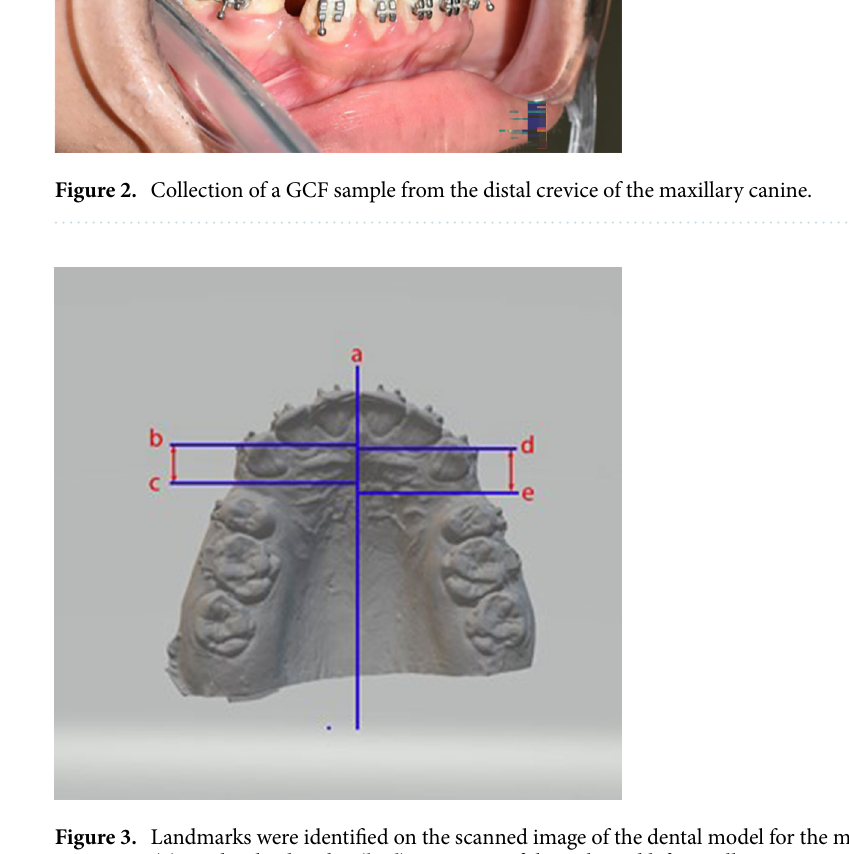
Figure 3. Landmarks were identified on the scanned image of the dental model for the measurement of canine retraction. ( a ). Mid-palatal raphe. ( b , d ). Cusp tips of the right and left maxillary canines, respectively. ( c , e ). Lines corresponding to the medial ends of the third right and left rugae,